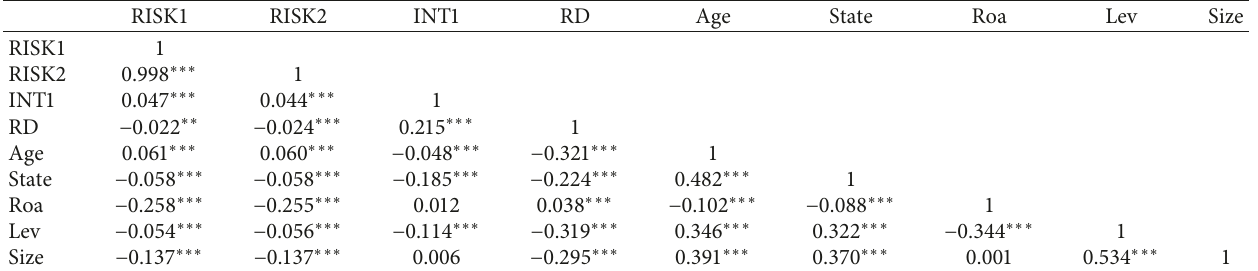
Table 2: Statistical analysis on correlation among major